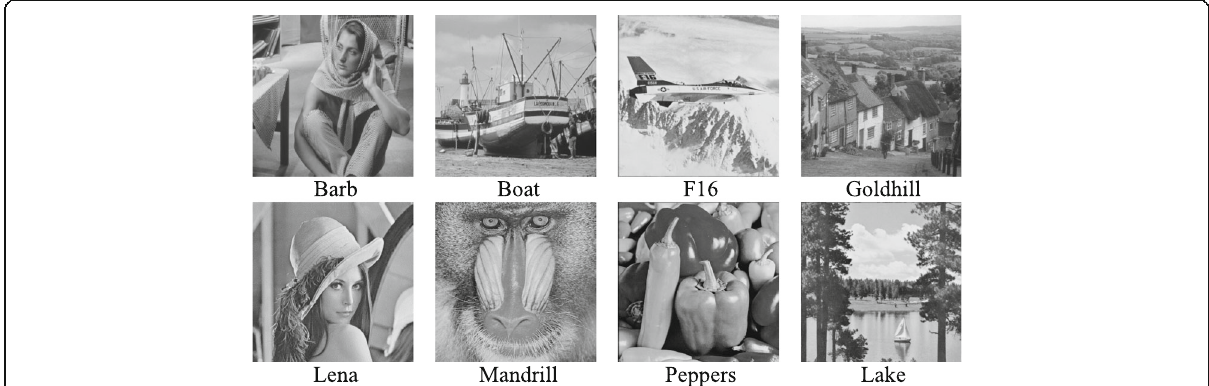
Fig. 7 Test images used in this study. Eight 512 × 512 grayscale test images that are widely used in the information hiding field were employed in this